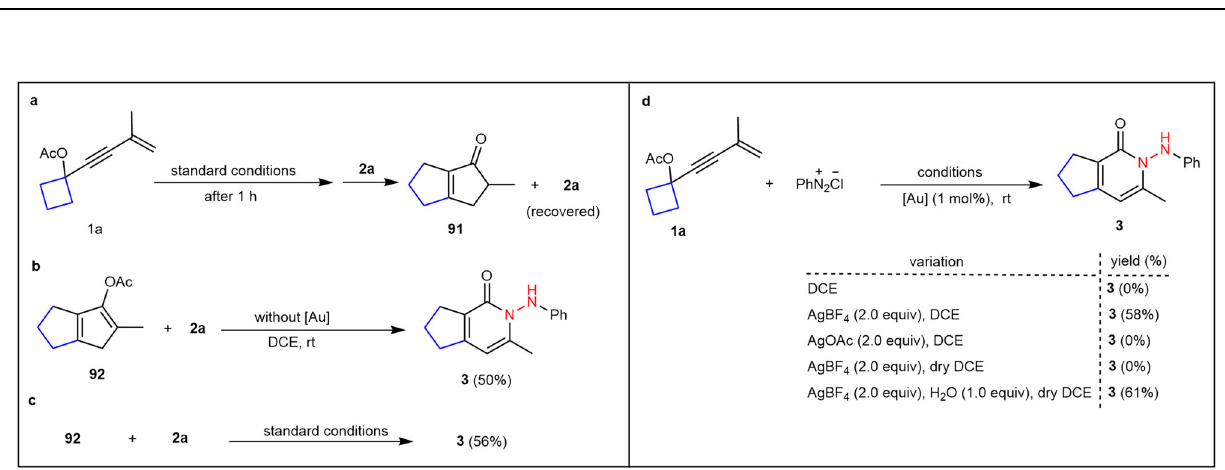
Fig. 5 | Gram-scale experiments and synthetic applications. a Gram-scale synthesis of 11 and N -protection of 11 . b Gram-scale synthesis of 78 and synthetic transfor- mations. TMDS, tetramethyldisilazane.